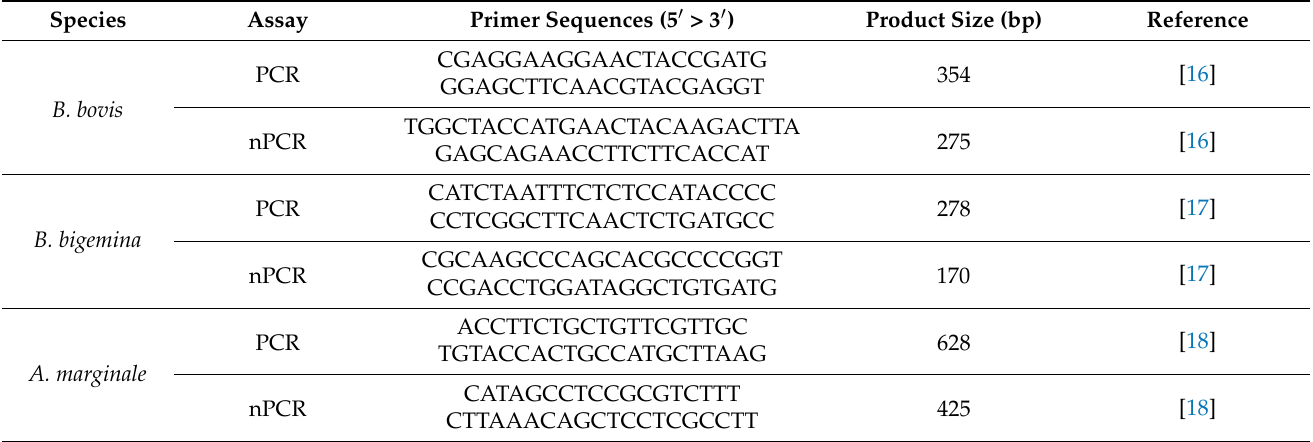
Table 1. Primer sequences used in the PCR